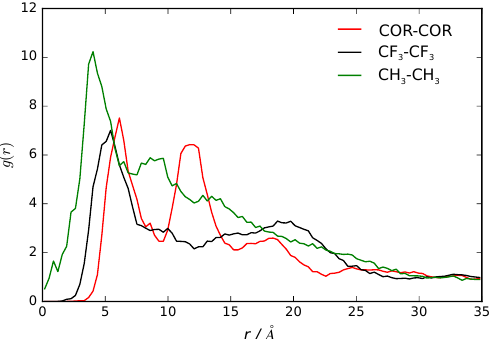
Figure 10. Radial distribution functions of the center of the central phenylene ring (COR), and CF 3